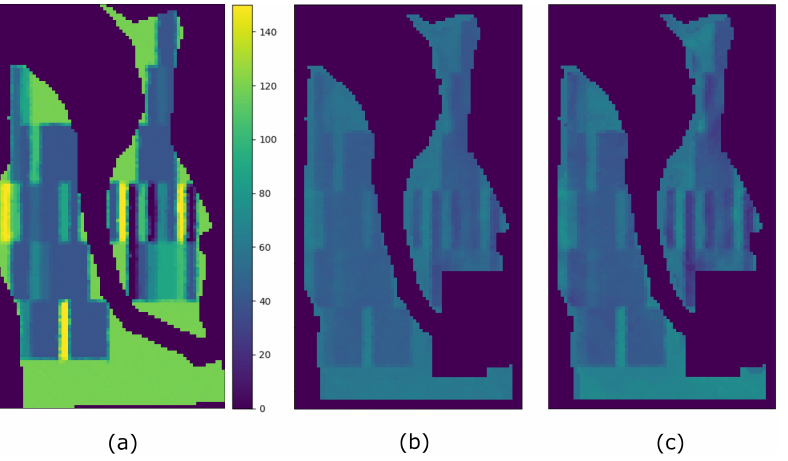
Figure 12. Comparison of the nitrogen rate map and the predicted yield map on the G1 field. ( a ) Nitrogen rate map. ( b ) SAE. ( c )